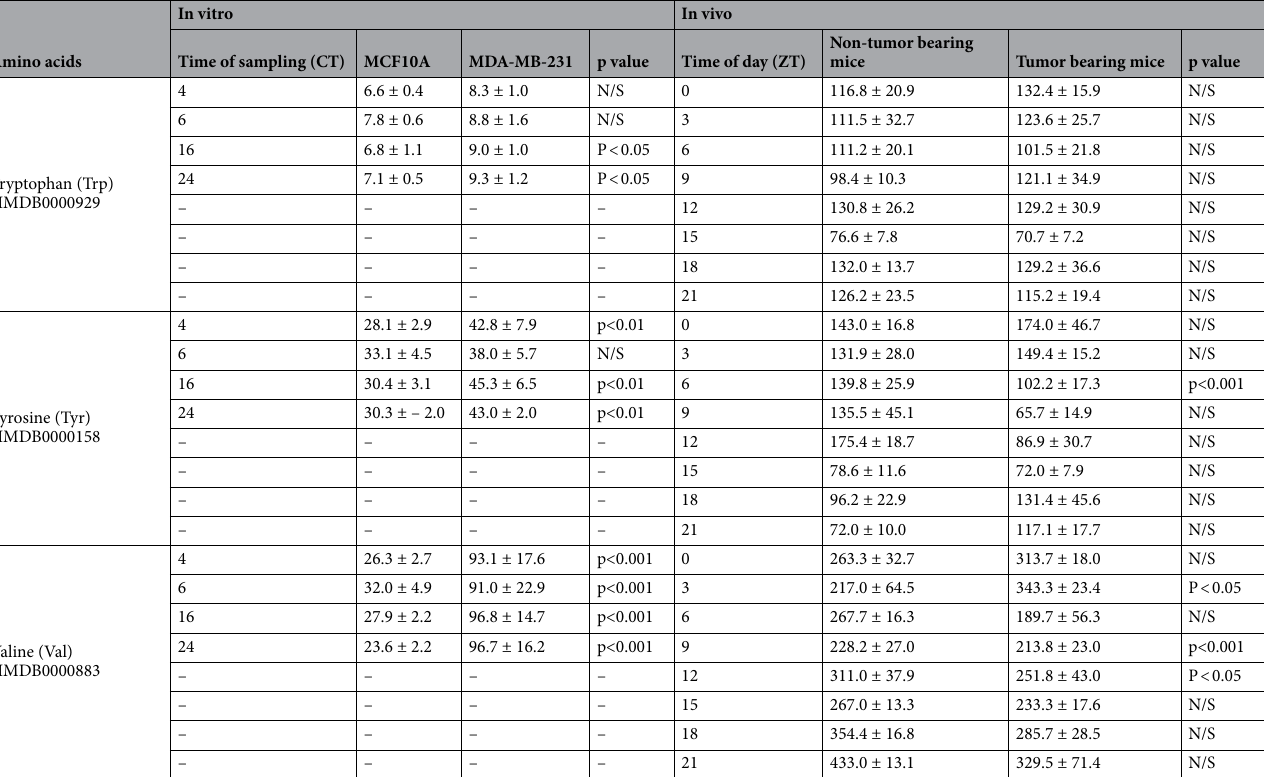
Table 1. Differences of amino acids concentrations (pM) in vitro (n = 5) and in vivo (n = 5) between normal and cancer conditions across 24 hours. All values are mean ± SD; p -values are from Two-way analysis of variance. *CT = culture time; ZT